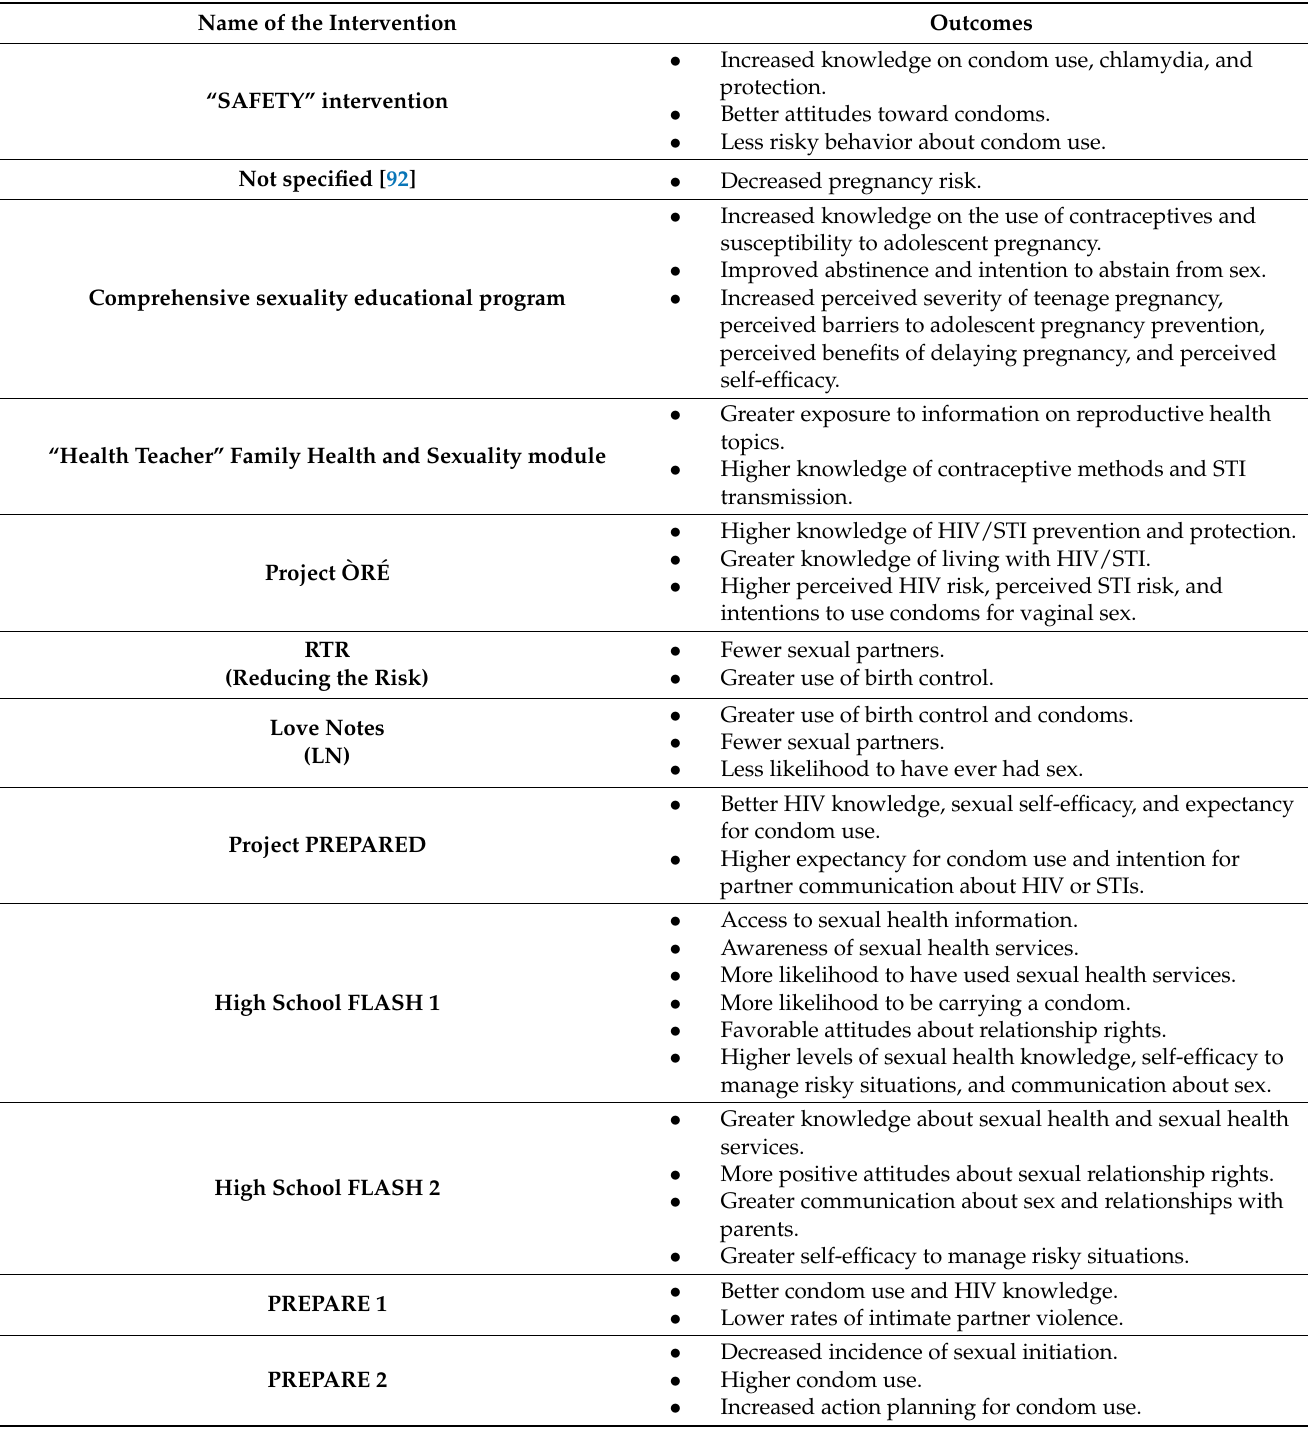
Table 5. Interventions outcomes (statistically